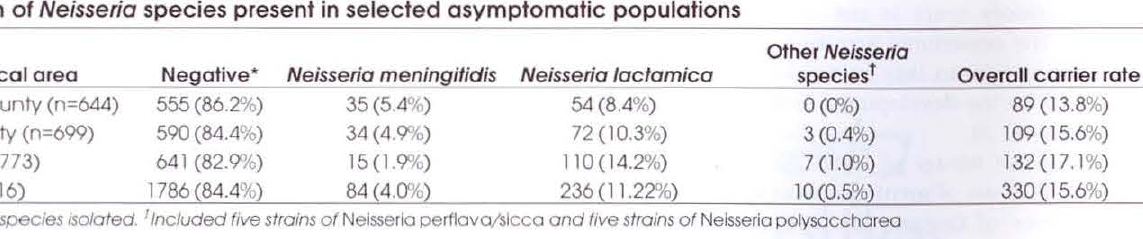
Distribution o f Neisseria species present in selected asymptomatic populations